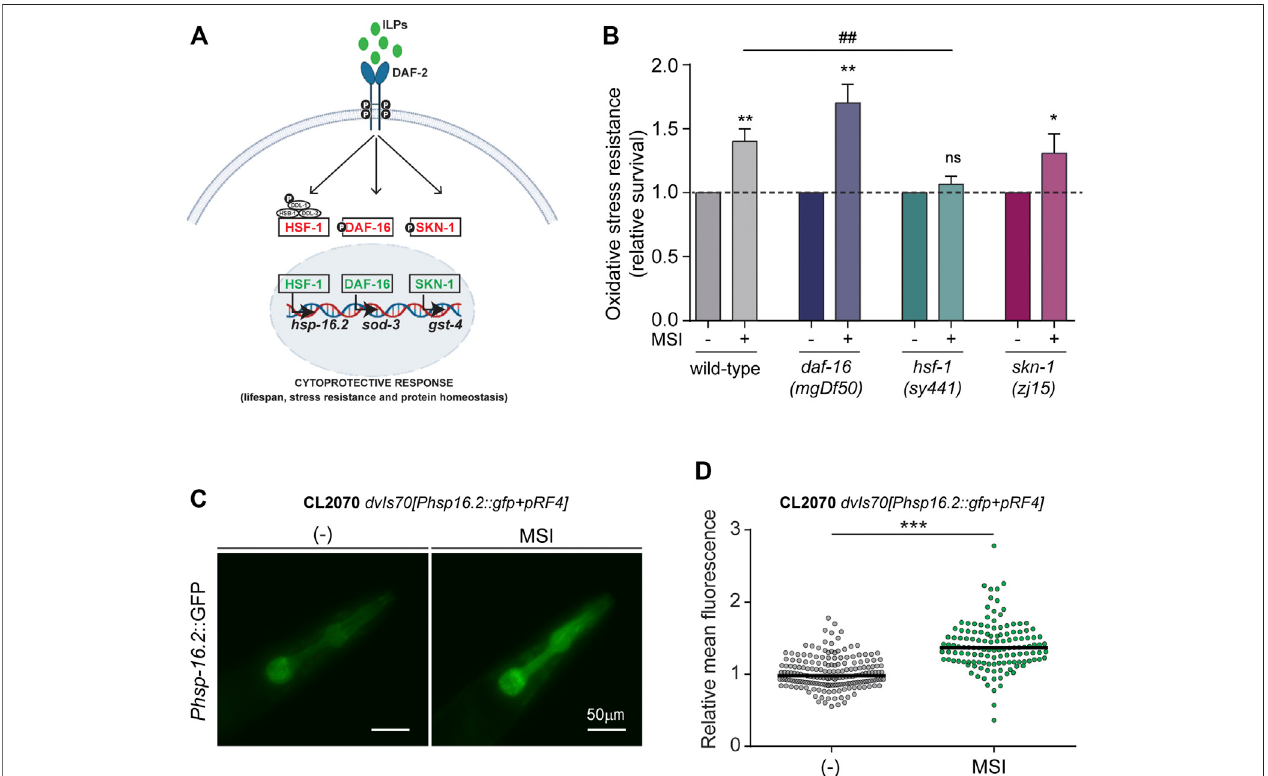
FIGURE 2 | Molecular pathways involved in the mechanism of stress resistance of MSI. (A) . Schematic diagram showing classical transcription factors involved in the DAF-2/IIS signaling pathway. Activation of the insulin/IGF-1 receptor ortholog, DAF-2 receptor, leads to phosphorylation and cytoplasmatic sequestration of the transcription factors (TFs) DAF-16/FOXO, HSF-1/HSF, and SKN-1/Nrf2. In contrast, downregulation of the DAF-2/IIS signaling permits the nuclearization of these TFs and the triggering of cytoprotective mechanisms. (B) . Oxidative stress resistance (10 mM FeSO4, 1 h) of wild-type, GR1307 daf-16(mgDf50) , PS3551 hsf- 1(sy441) , and QV225 skn-1(zj15) mutant animals exposed to MSI. Data are shown as mean ± SEM from at least 4 independent experiments ( n = 60 – 80 animals per experiment per condition). Statistical differences were evaluated by comparison of means (Student ’ s t-test for daf-16 animals) or medians (Mann-Whitney Rank Sum Test for wild-type and hsf-1 worms). *represents p -value compared with the same strain without MSI and # represents p -value for wild-type and hsf-1 mutant comparison upon MSI exposure (ns, not signi fi cant, * p < 0.05, ** p < 0.01, ## p < 0.01). (C) . Representative fl uorescence micrographs depicting the expression of the stress-responsive gene hsp-16.2 in the absence and presence of 50 μ M MSI. (D) . Quanti fi cation of hsp-16.2 expression by measuring fl uorescence intensity in the pharynx region. Data are shown in a scatter-dot plot graph, with a horizontal line indicating the median of each dataset, from fi ve independent experiments and 25 – 40 animals per experiment per condition. Statistical differences were evaluated by Mann-Whitney Rank Sum Test (*** p <